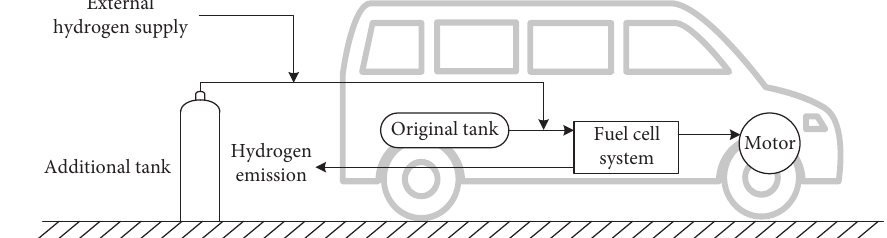
Figure 1: Sketch of off-board hydrogen supply.